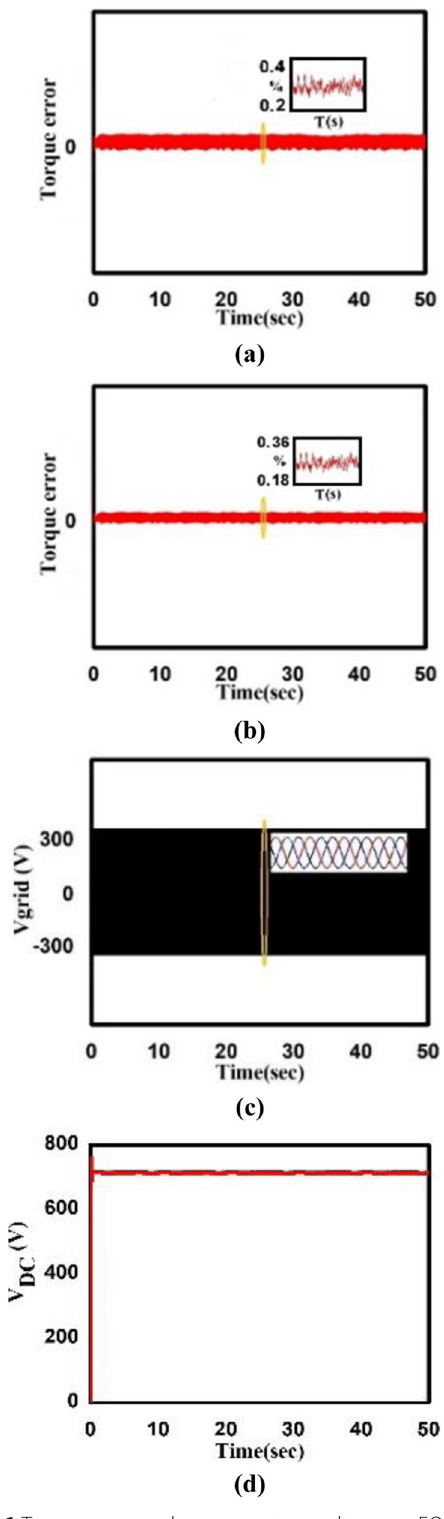
Fig. 16 Torque error and power system voltages. a FOC- based torque error. b Adaptive control-based torque error. c Fig. 15 Speed tracking error. a FOC-based ω r = ω (cid:3) error. b r Stable grid side voltage. d Optimized DC-link Adaptive control-based ω r = ω (cid:3) error r